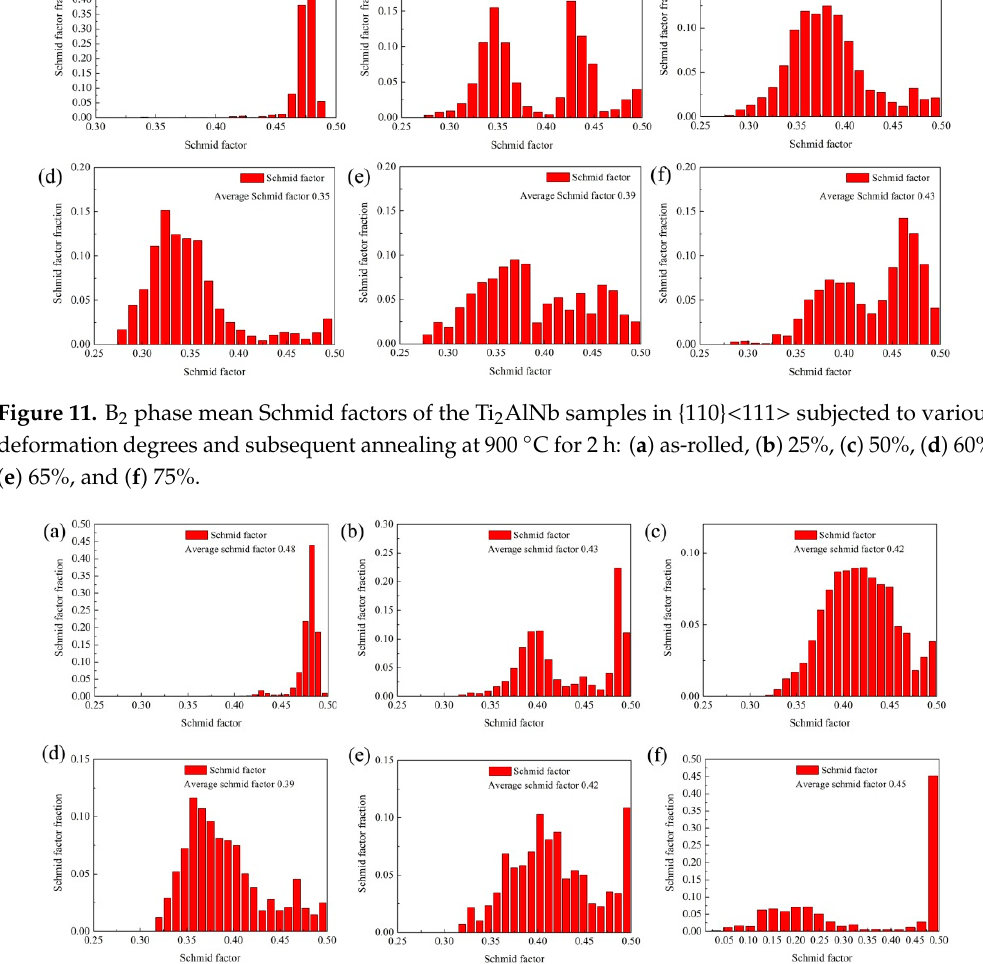
Figure 12. B 2 phase mean Schmid factors of the Ti 2 AlNb samples in {112}<111> subjected to various deformation degrees and subsequent annealing at 900 °C for 2 h: ( a ) as-rolled, ( b ) 25%,( c ) 50%, ( d ) 60%, ( e ) 65%, and ( f ) 75%.